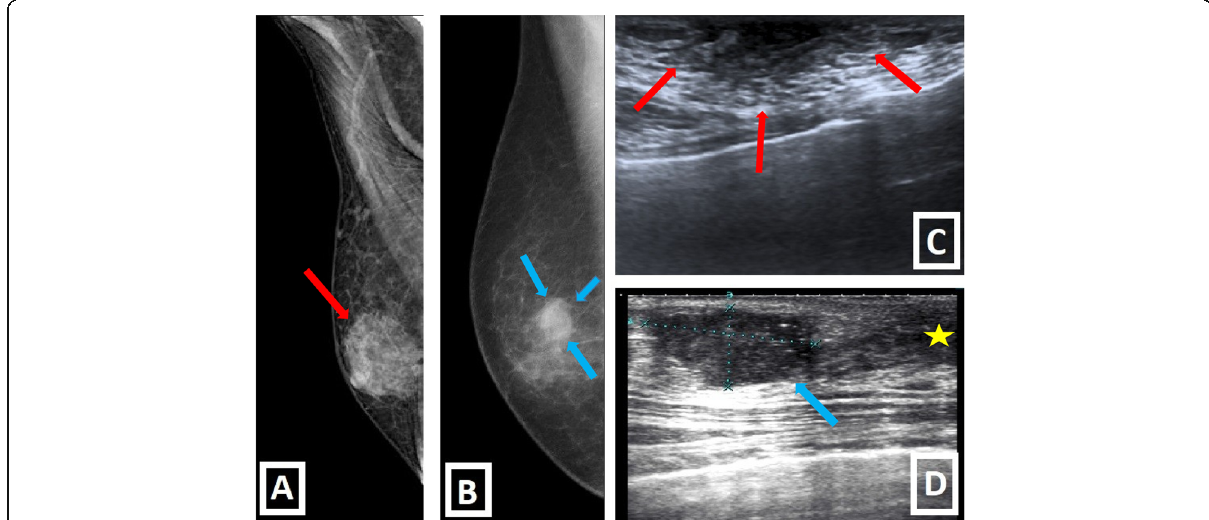
Fig. 5 Gynecomastia vs. Primary breast malignity. a – c Fan-shaped central subareolar opacity, in mammography, and disk-shaped hypoechoic retroareolar tissue, in US (red arrows), with bilateral involvement (not shown) are typical imaging findings of gynecomastia (nodular form). b – d IDC of male breast. Irregular lesion with slightly eccentric location according to the nipple and higher density than accompanying background gynecomastia is seen in mammography. US shows ill-defined, hypoechoic, solid mass located outside of the nipple-areolar complex (yellow star) with unilateral involvement (blue